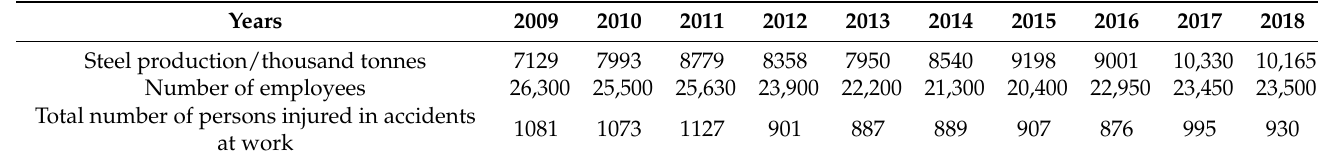
Table 2. Key information about Polish steel production (own study based on [66,67]).